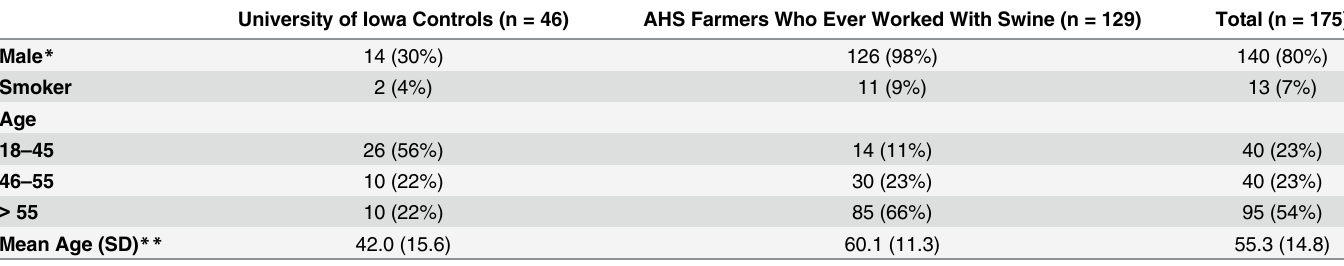
Table 1. Characteristics of All Study Participants (n =